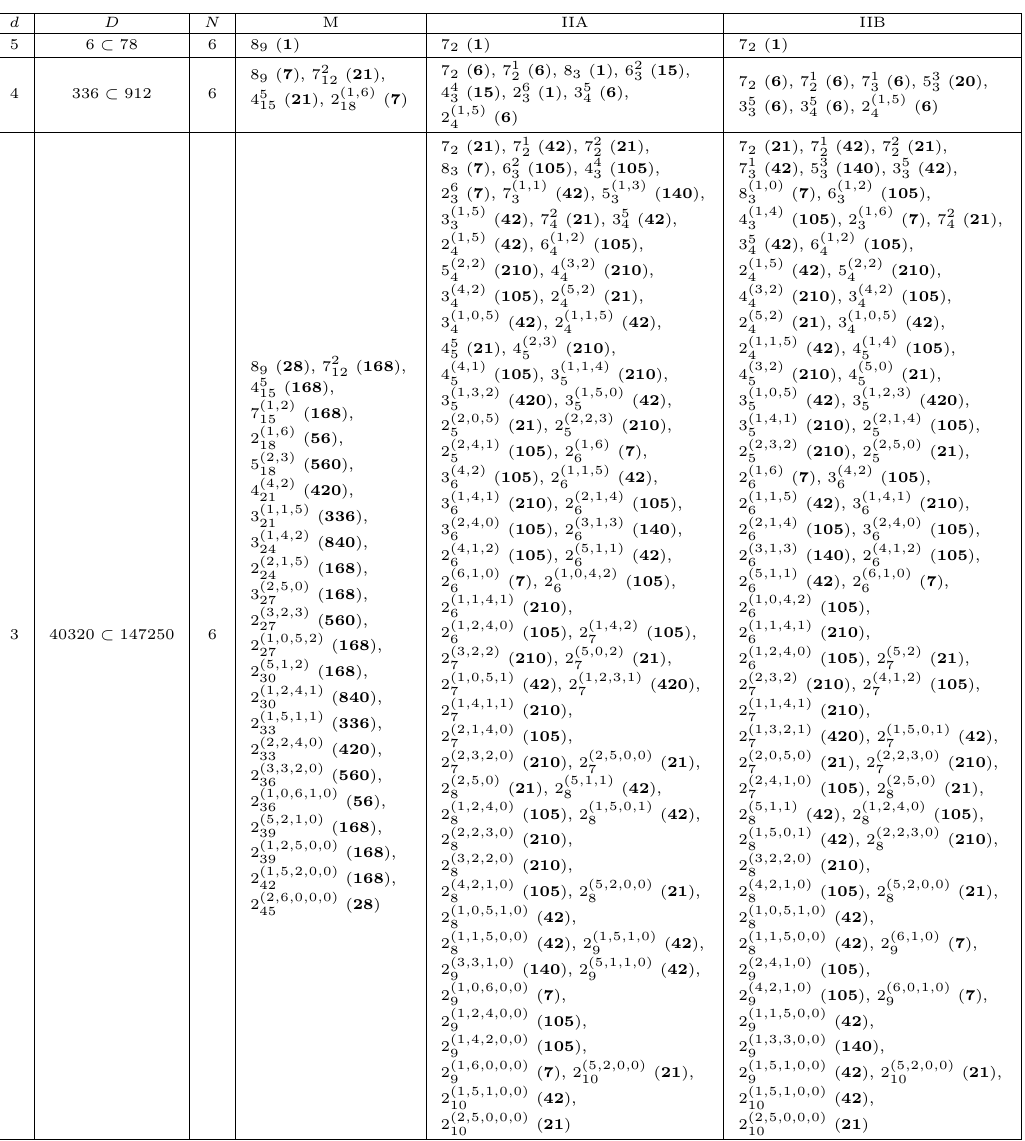
Table 16 . Missing states in the string